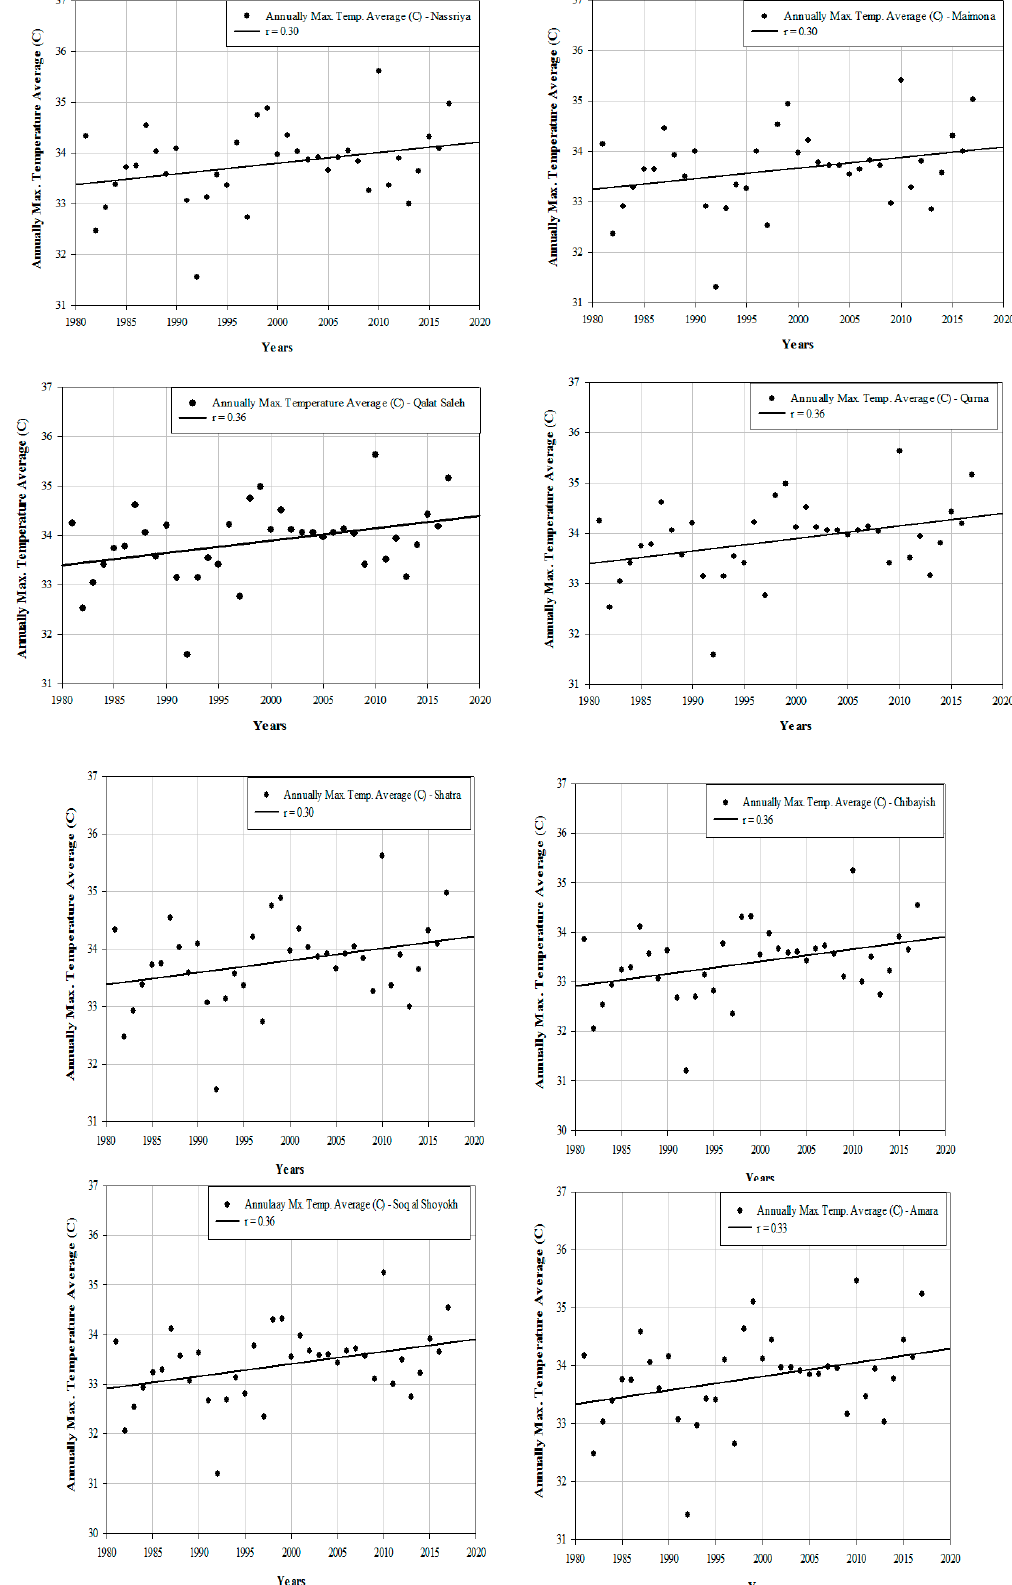
Figure 7. Changes of the Annual maximum temperature average in period of 1981–2016.